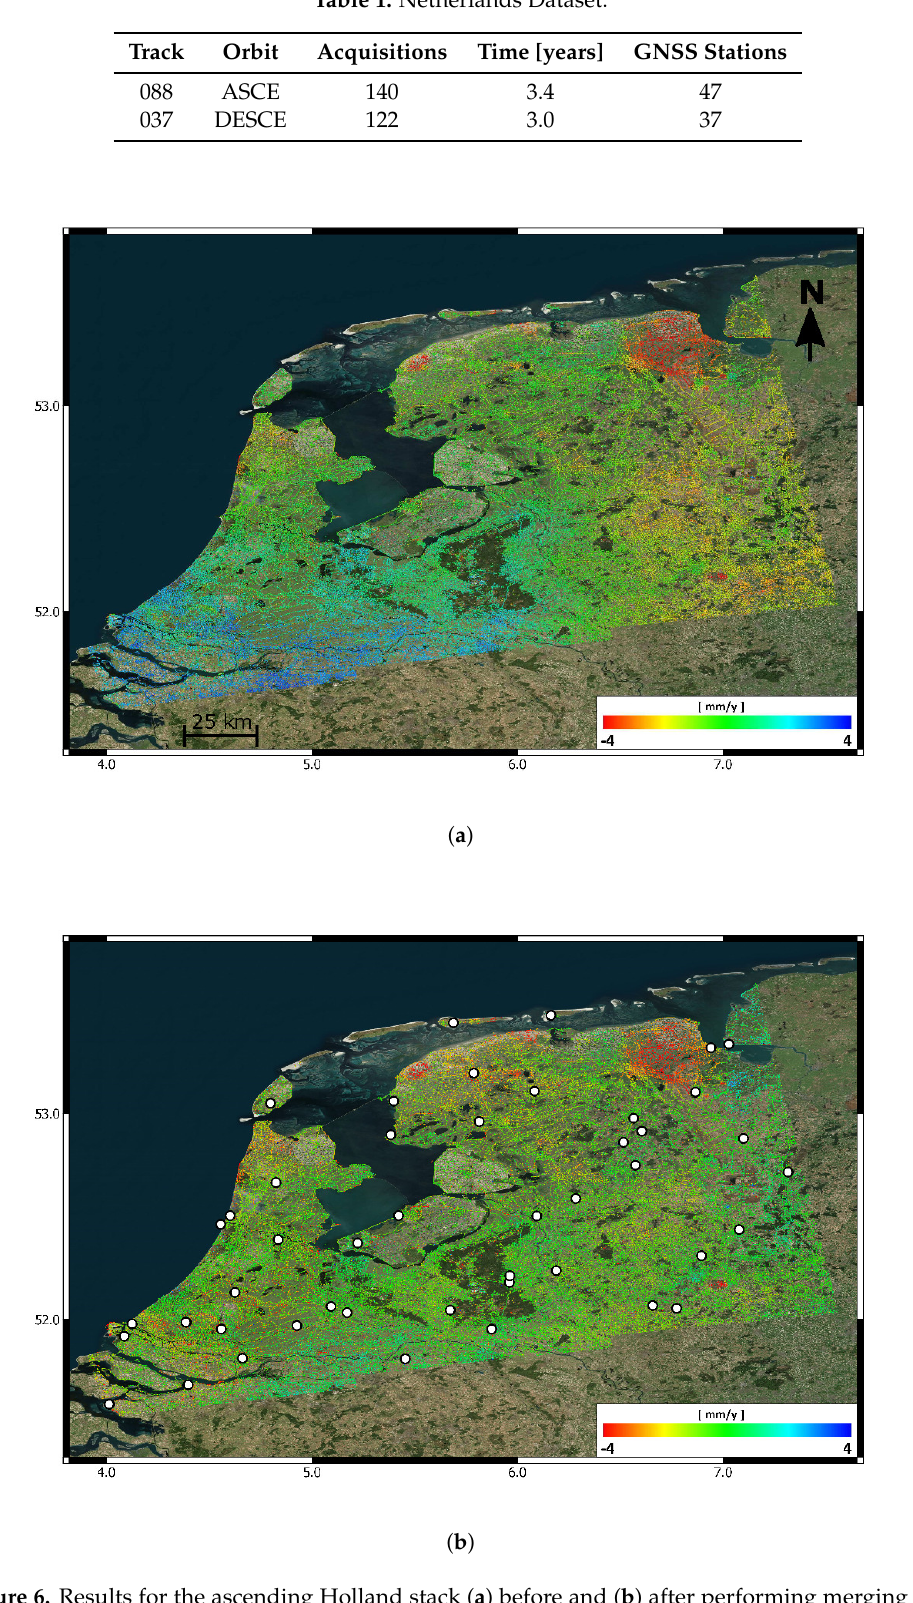
Figure 6. Results for the ascending Holland stack ( a ) before and ( b ) after performing merging with GNSS data. In ( b ), the GNSS stations used are displayed with black–white